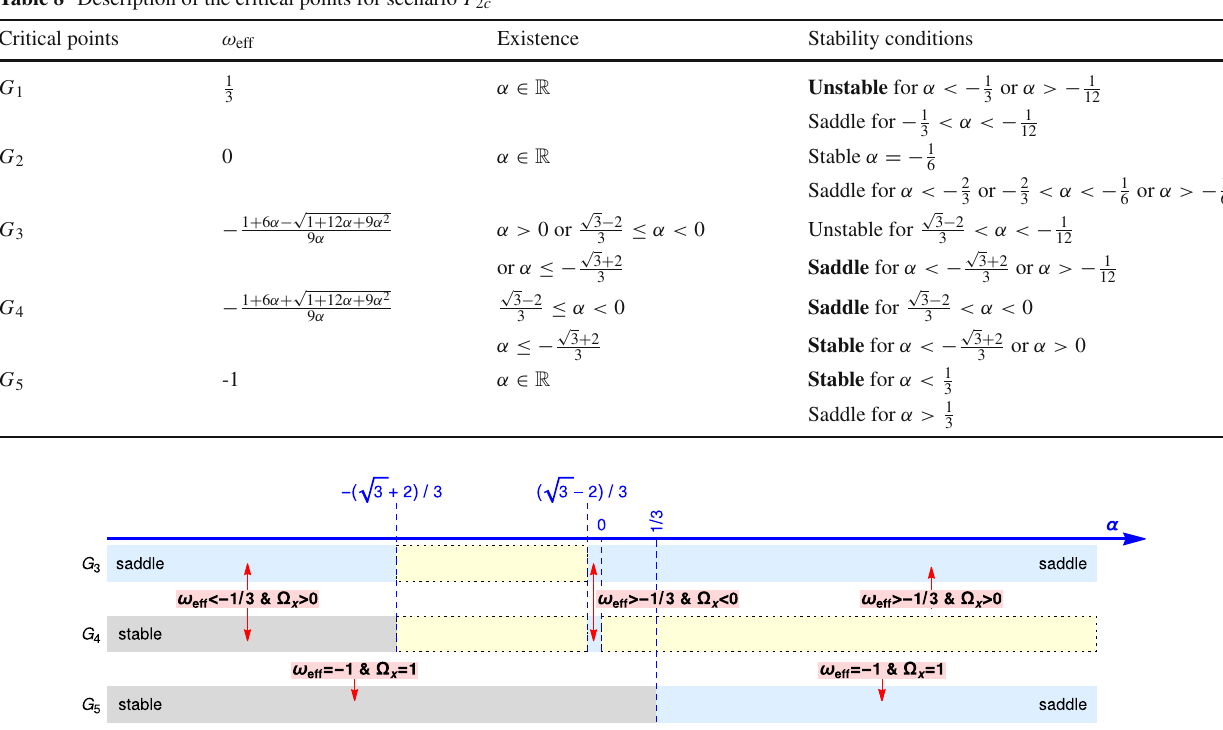
Table 8 Description of the critical points for scenario Γ 2 c